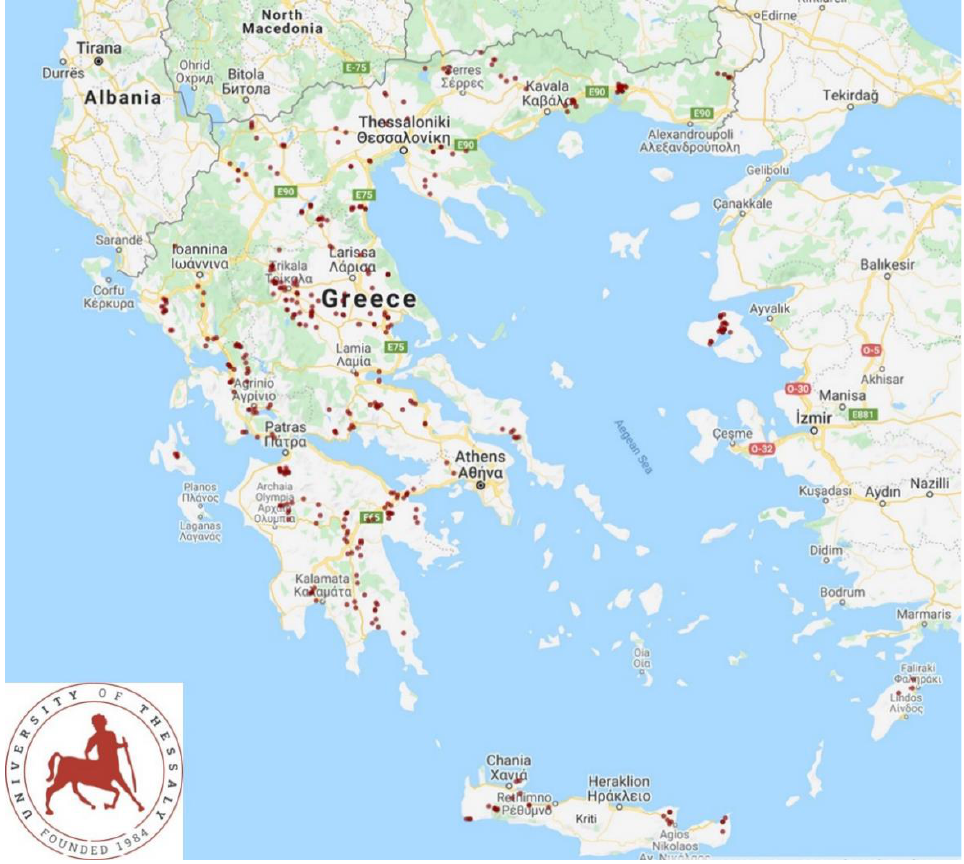
Figure 1. Location of the 444 small ruminant farms around Greece, which were visited to record details on patterns of reproductive management.